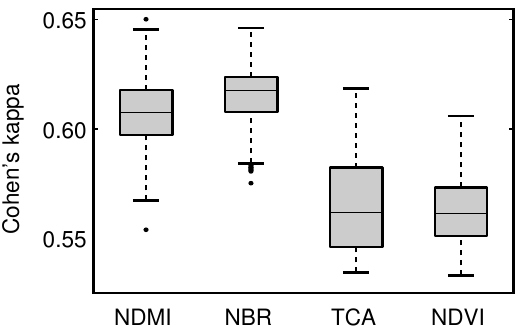
Figure 5. Range of Cohen’s kappa over all parameter combinations for four different vegetation